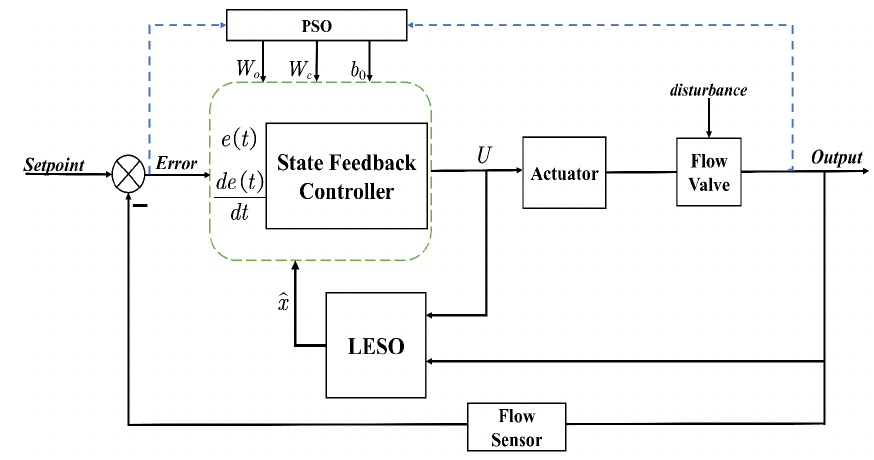
Figure 4. Structure of LADRC.